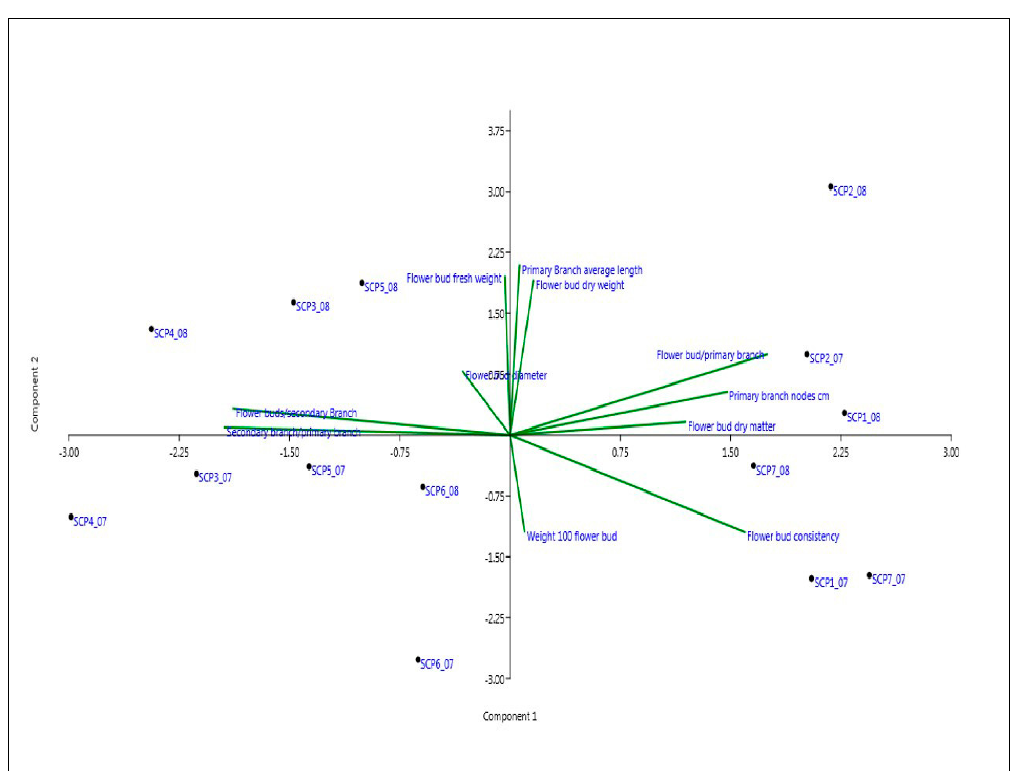
Figure 4. Factor weight and grouping of Capparis spinosa subsp. rupestris accessions.